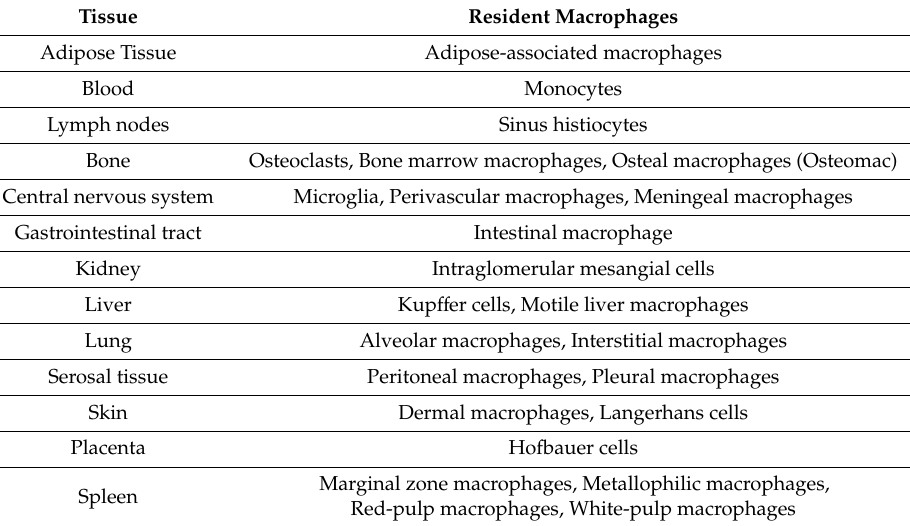
Table 2. Tissue Resident